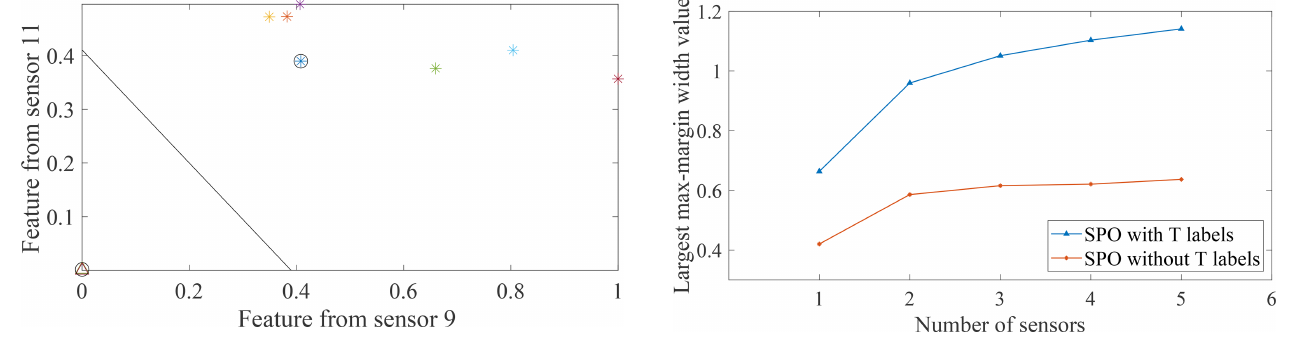
Figure 11. Distribution of MSD-based features from two sensors providing the two largest minimum-feature values.